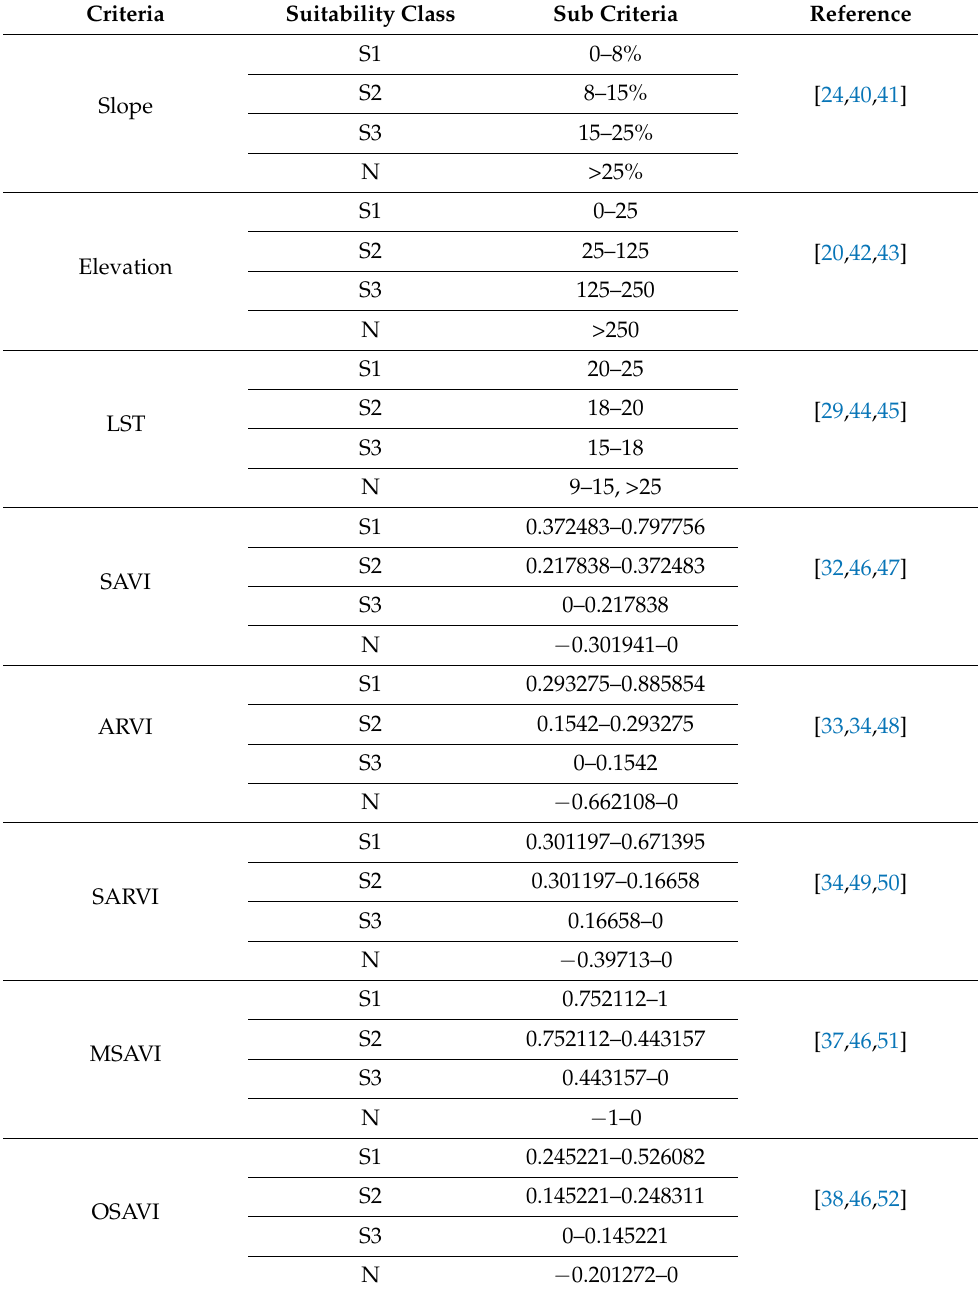
Table 2. Criteria reclassification for weighted linear